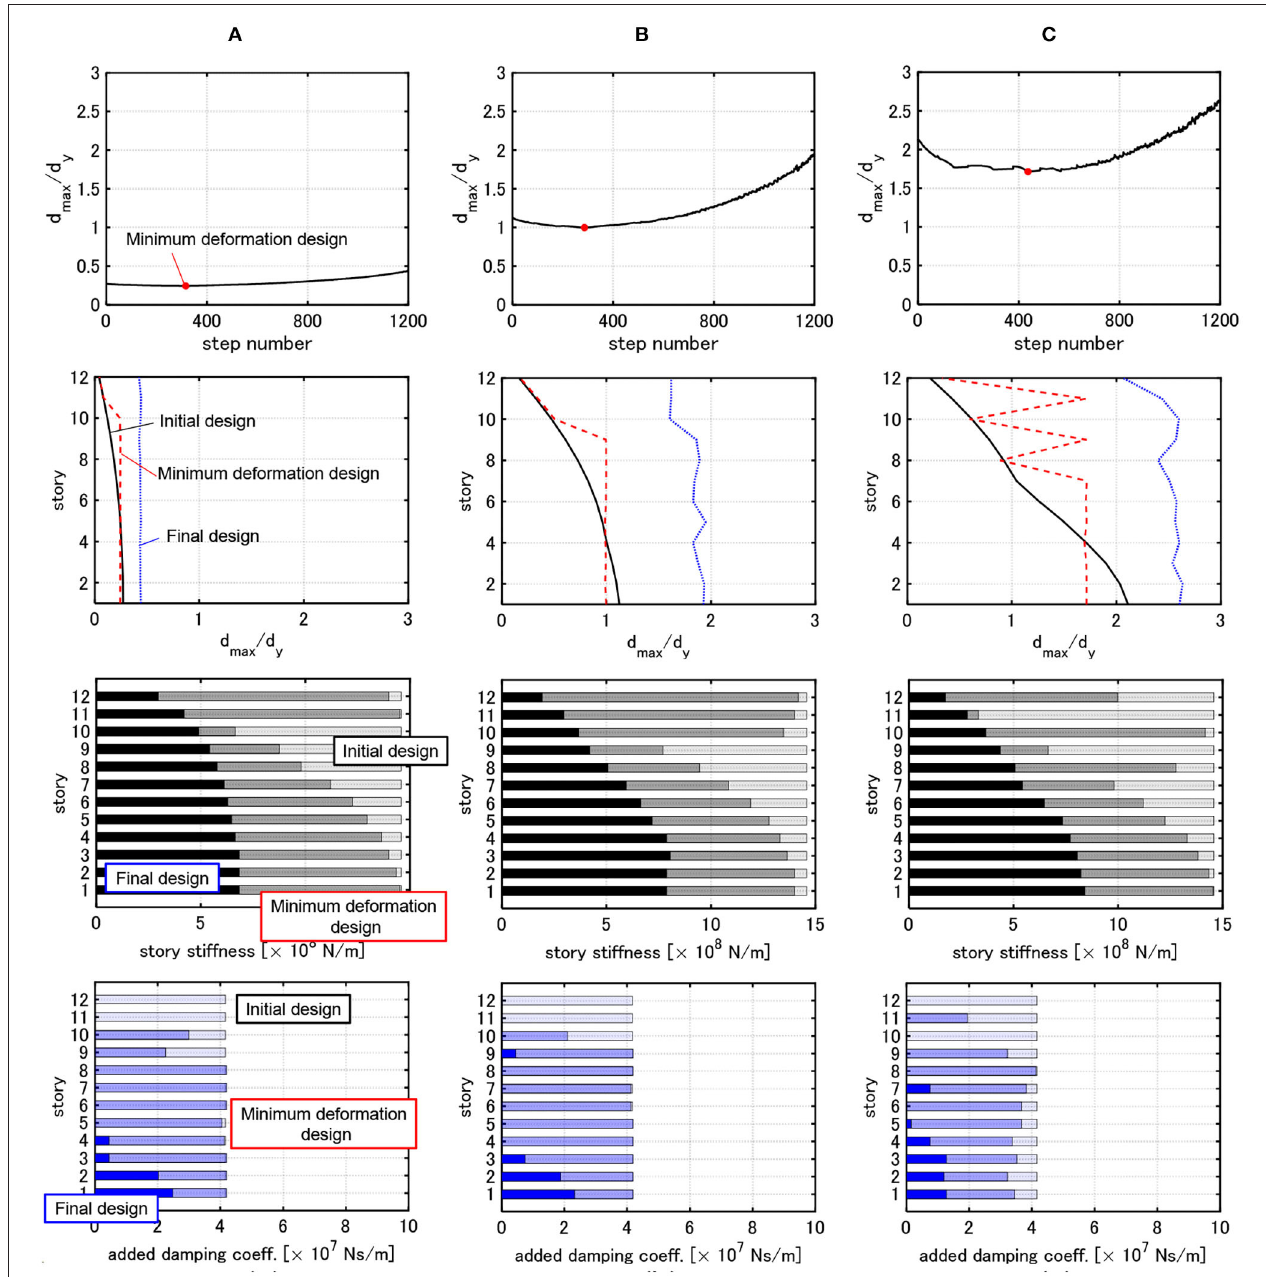
FIGURE 8 | Change of maximum deformation, distribution of d max, i / d y , distribution of story stiffness and distribution of damper damping coefficient of 3 cases with W cF = 5 × 10 7 [ Ns / m ]. (A) Model designed under critical double impulse with V = 0.25[ m / s ]. (B) Model designed under critical double impulse with V = 1.0[ m / s ]. (C) Model designed under critical double impulse with V = 1.5[ m / s ].